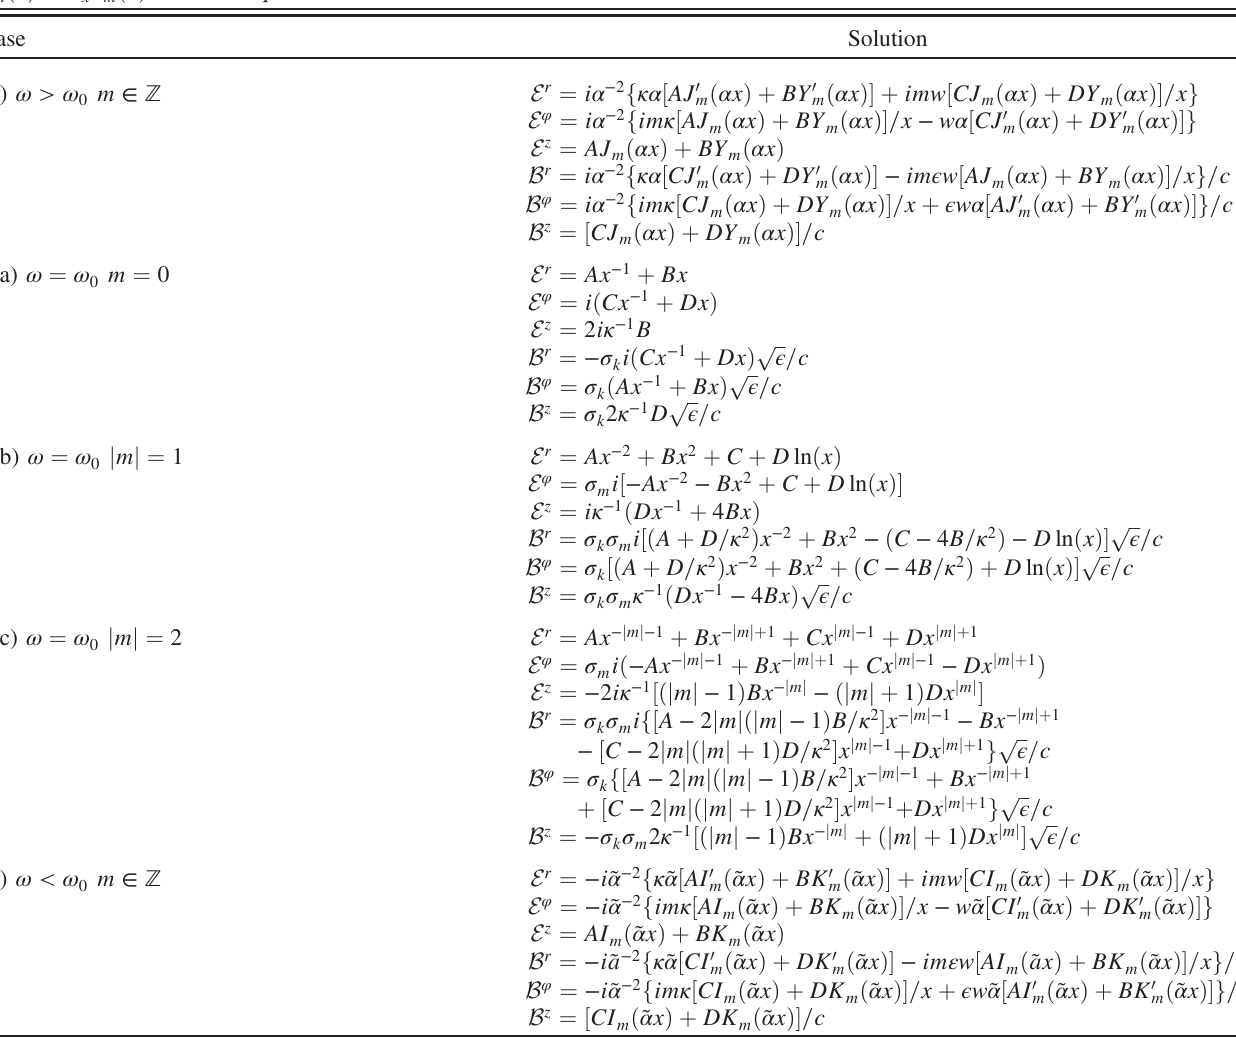
TABLE IV. Radial partial waves of the solutions Eq. (A9) to Maxwell ’ s equations using cylindrical coordinates in the spectral domain. . In vacuum outside the fiber, ω 0 ¼ ω Inside the fiber, ω 0 ¼ ω v are amplitudes. The radial dependence is given by Bessel functions J below the light line, and by polynomials and the natural logarithm ln on the light line. The prime indicates the first derivative J 0 x Þ ¼ ∂ J x Þ . All other quantities used are defined in Table m ð x m ð